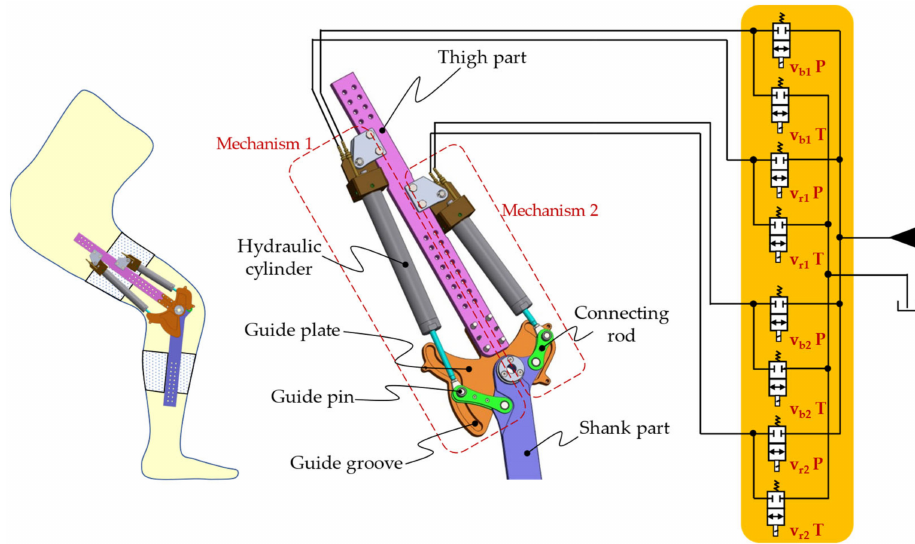
Figure 1. Knee exoskeleton attached to the human leg ( left ); details of the exoskeleton design and the digital hydraulic drive ( right